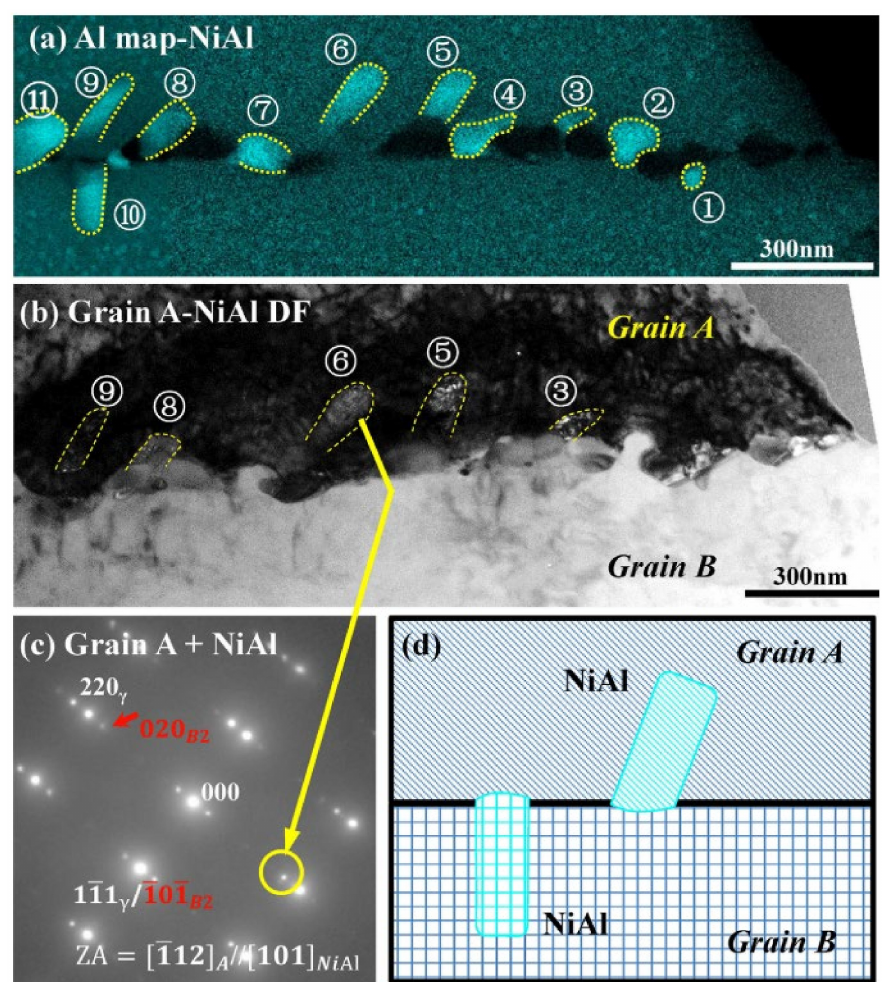
Figure 4. Preferred growth orientation of the NiAl phase. ( a ) STEM-EDS mapping of Al element; ( b ) TEM DF image using the NiAl diffraction spot in ( c ); ( c ) the corresponding SAD pattern of grain A with [ ¯112 ] // [ 101 ] ; ( d ) schematic view of NiAl location at GB NiAl γ